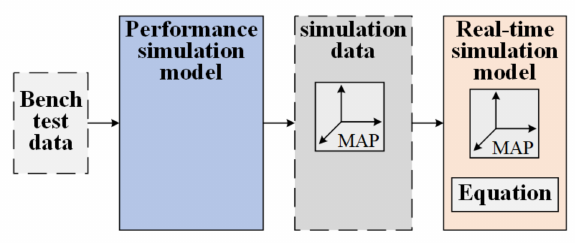
Figure 3. Modeling logic